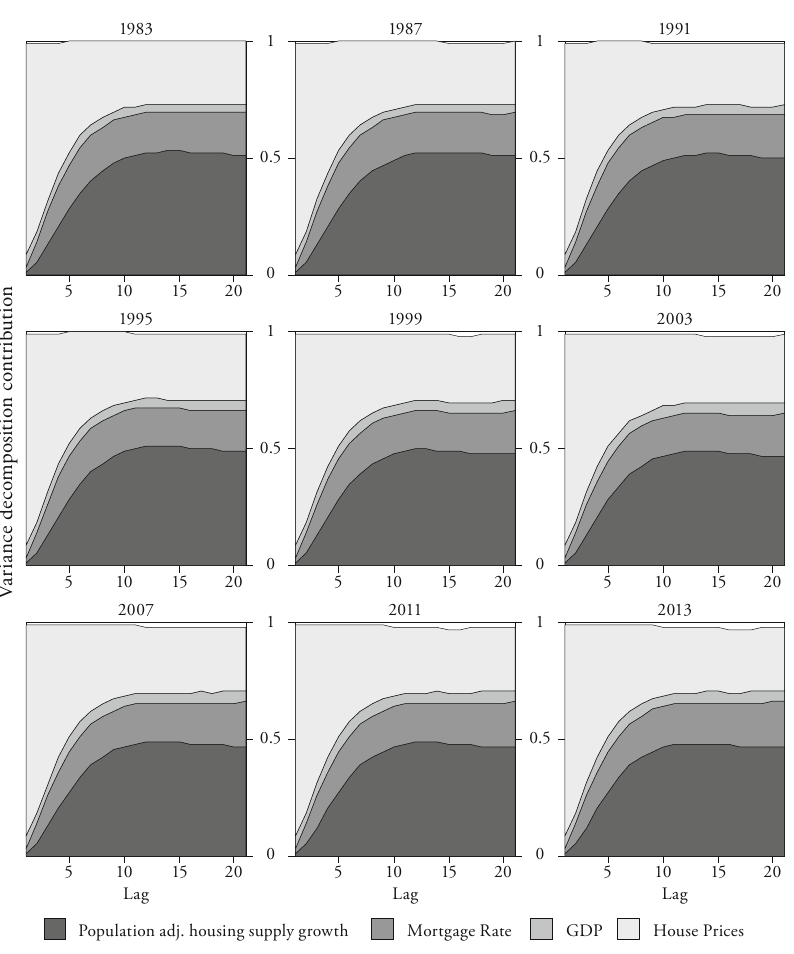
Figure 6: Variance Decomposition of House